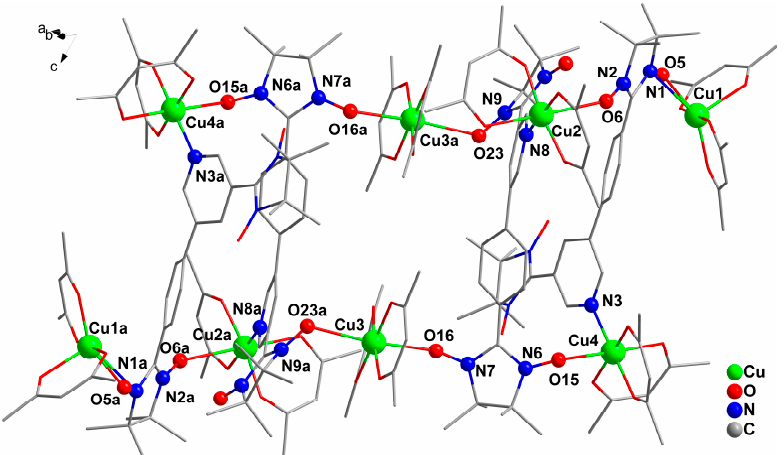
Figure 1. Crystal structure of 1 (fluorine and hydrogen atoms are omitted for the sake of clarity; symmetry code, a: x, y, 1+z).